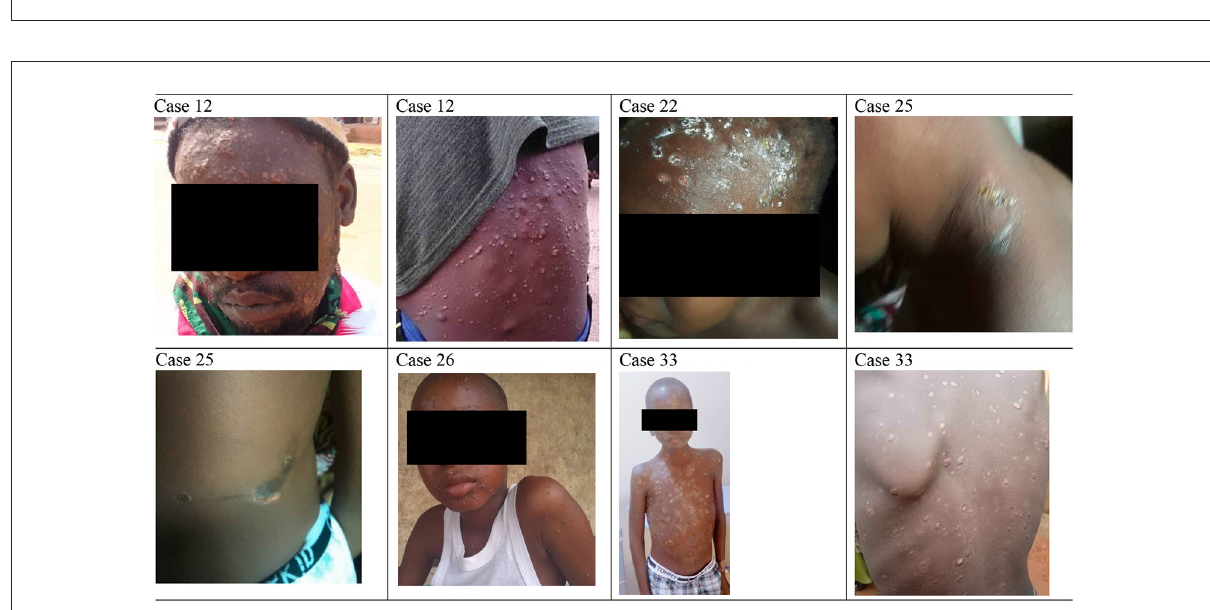
FIGURE6 Spectrum of skin lesion observed in follow-up patients. Case 12 (MPX and VZ), Case 22 (MPX and VZ), Case 25 (MPX), Case 26 (MPX and VZ), and Case 33 (MPX and